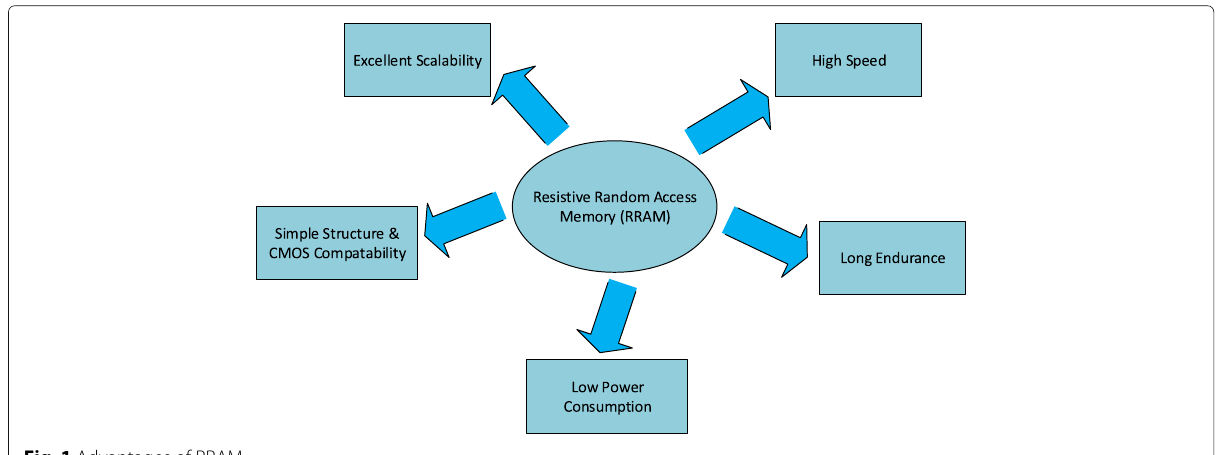
Fig. 1 Advantages of